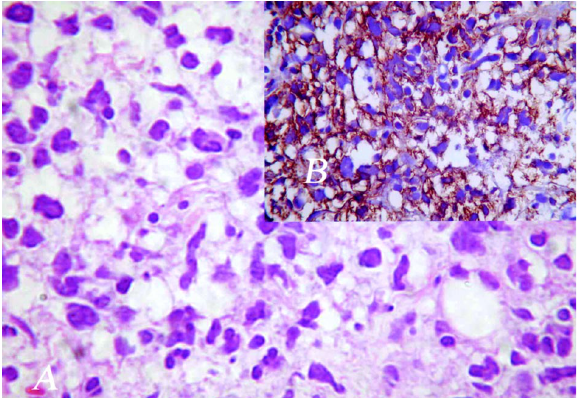
Figure 2 – A) – Diffuse large cells lymphoma. B) – Positivity of tumor cells to CD20, characterizing B-cell lymphoma.